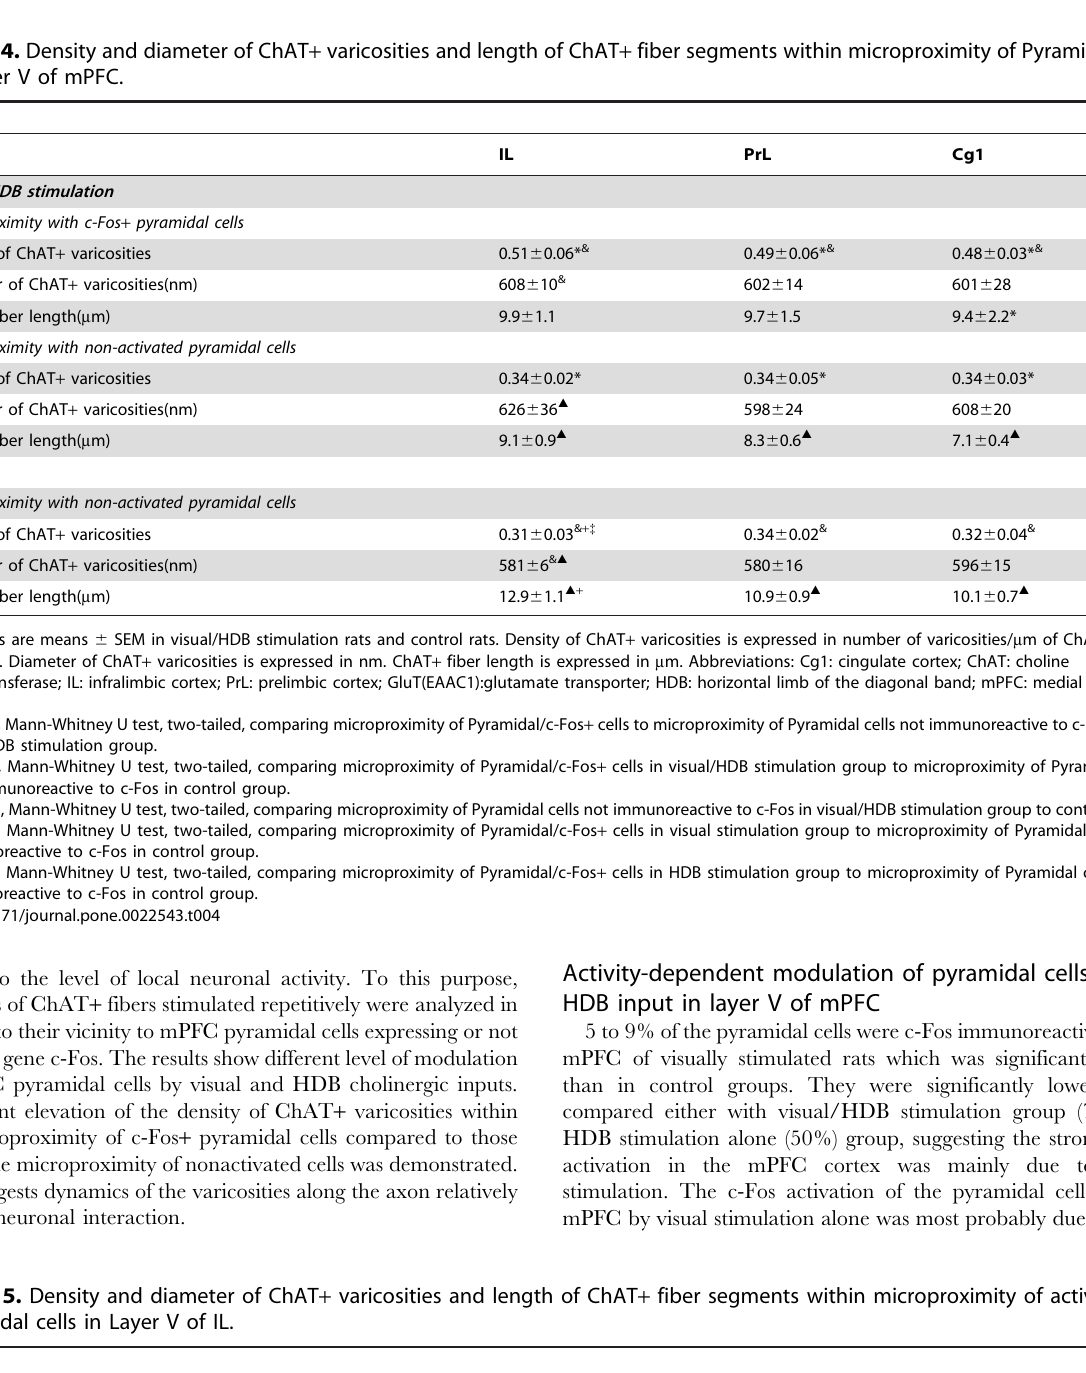
Visual stimulation HDB stimulation Visual/HDB